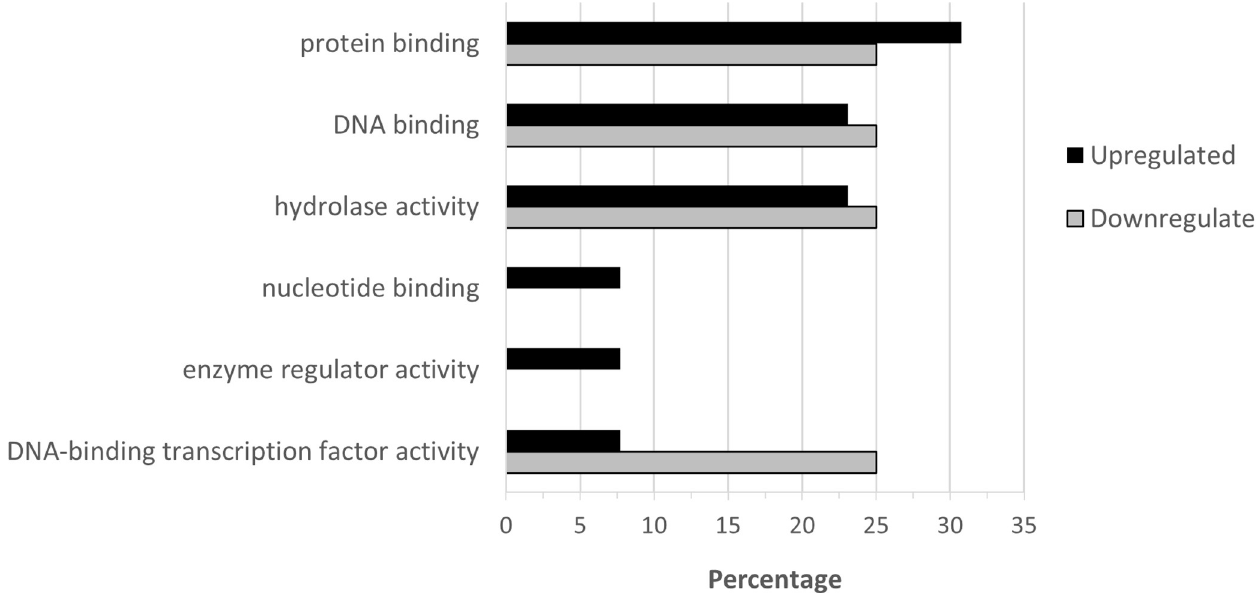
Fig 10. Percentage of upregulated (n = 13) and downregulated (n = 4) transcripts from the Top 50 differentially expressed genes (DEGs) when Populus Tremuloides nickel resistant genotypes were compared to nickel susceptible genotypes. Only transcripts with assigned gene ontology were included and these were grouped by molecular function using BLAST2GO (Omics Box).